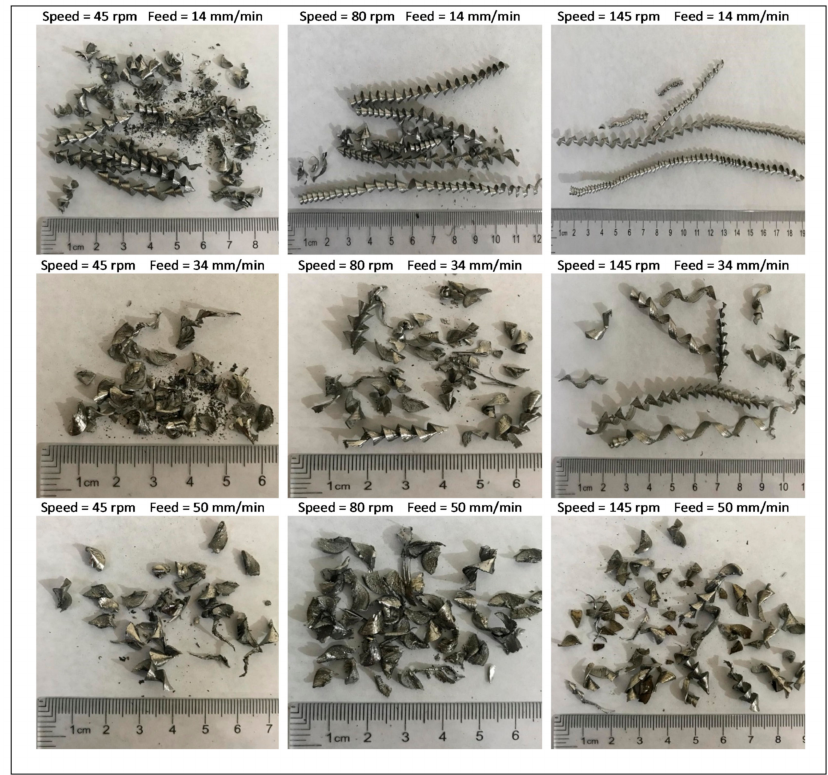
Figure 11. Chips morphology at varying cutting speeds and feed rates.